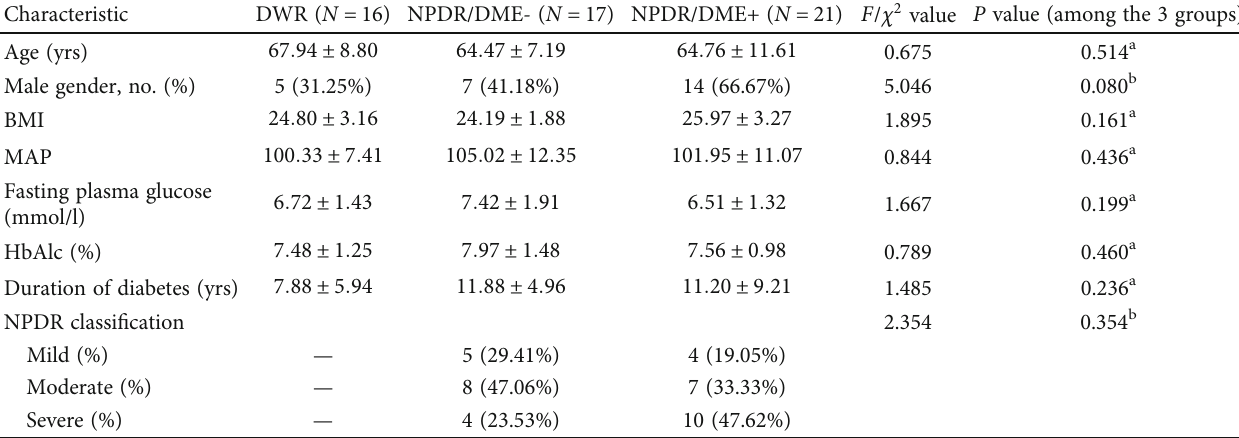
Table 1: Demographic characteristics of the 3 groups.